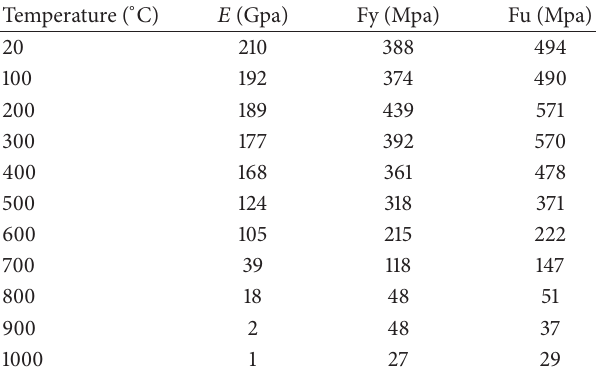
Table 1: Mechanical properties of the structural